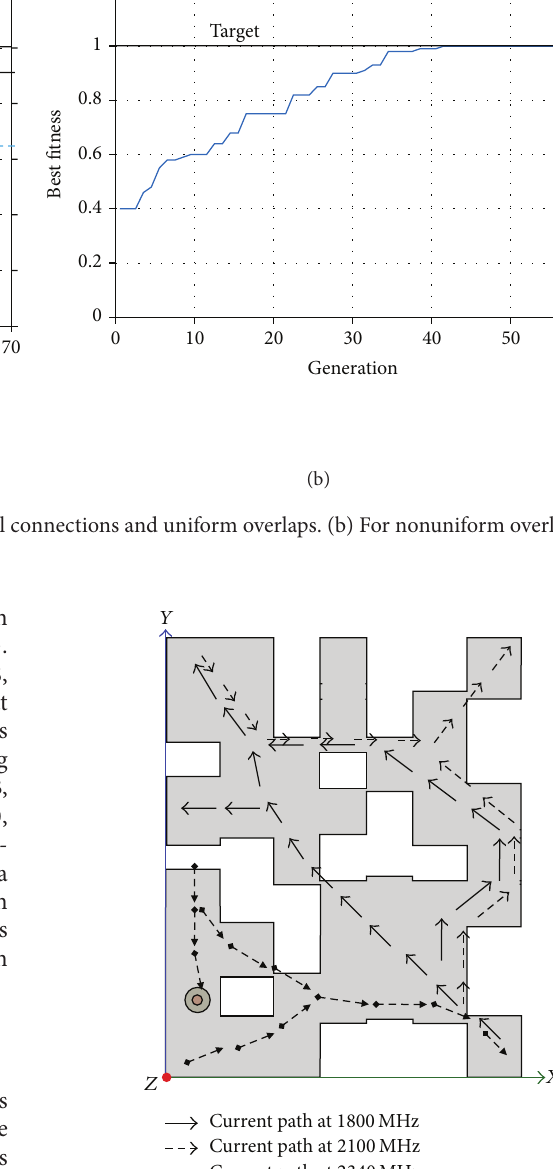
Figure 8: Current paths at resonant